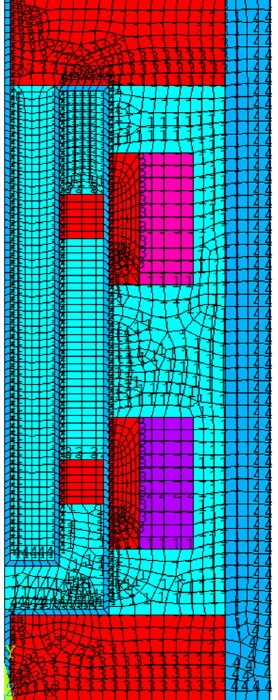
Figure 7. Meshing diagram of annular multi-channel MR valve.